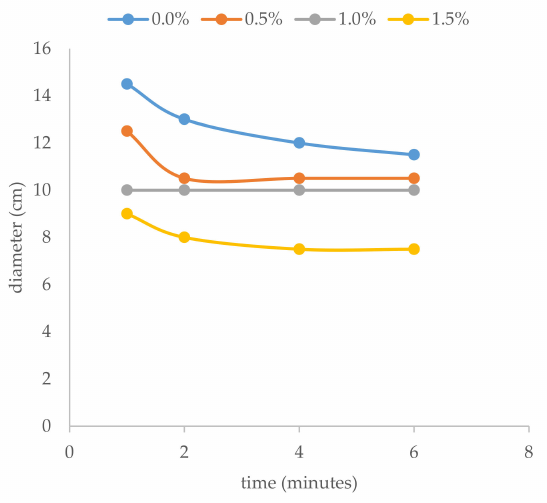
Figure 5. Evolution of workability with time and percentage of setting